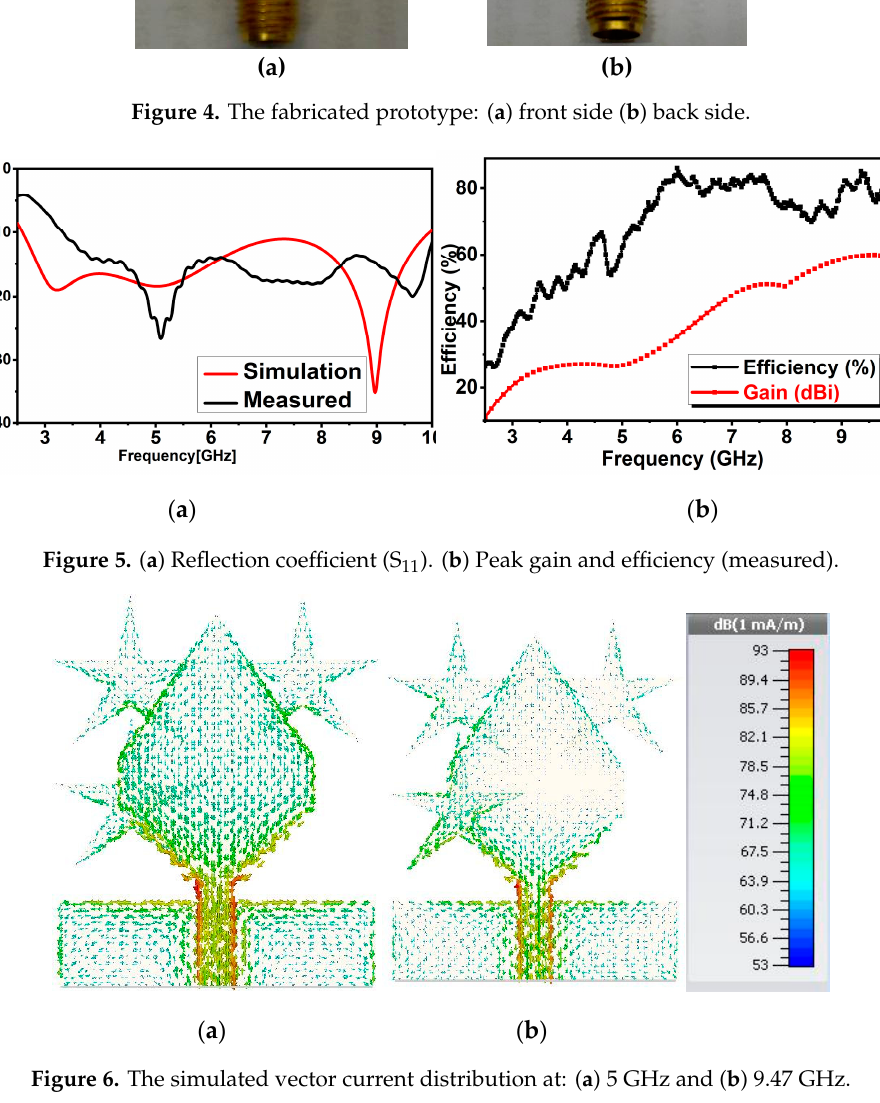
Figure 6. The simulated vector current distribution at: ( a ) 5 GHz and ( b ) 9.47 GHz.